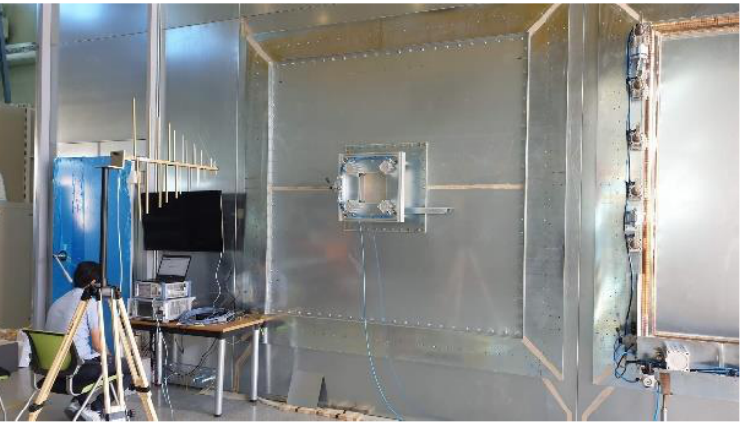
Figure 11. Shielding effectiveness measurement of concrete.